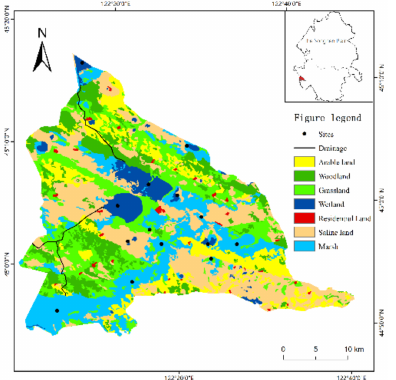
Figure 1. Location of the study area and sample